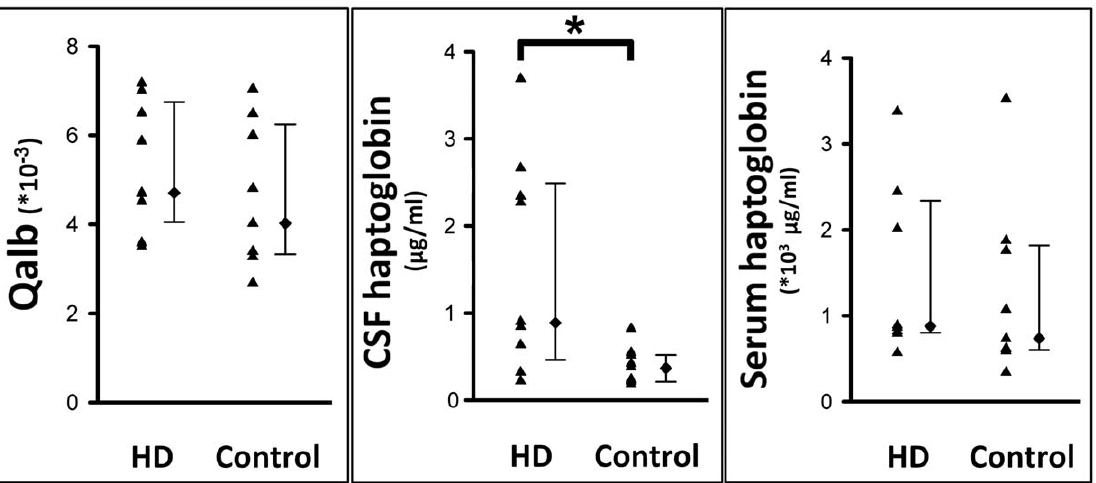
Figure 4. Qalb, CSF haptoglobin, and serum haptoglobin concentration in HD patients. Data are illustrated in scatter plots with median and interquartile rang. Either the Qalb or serum haptoglobin concentration was not different between HD (n=9) and the controls (n=9), whereas the CSF haptoglobin was significantly increased in HD. * p , 0.05, Mann-Whitney U test.